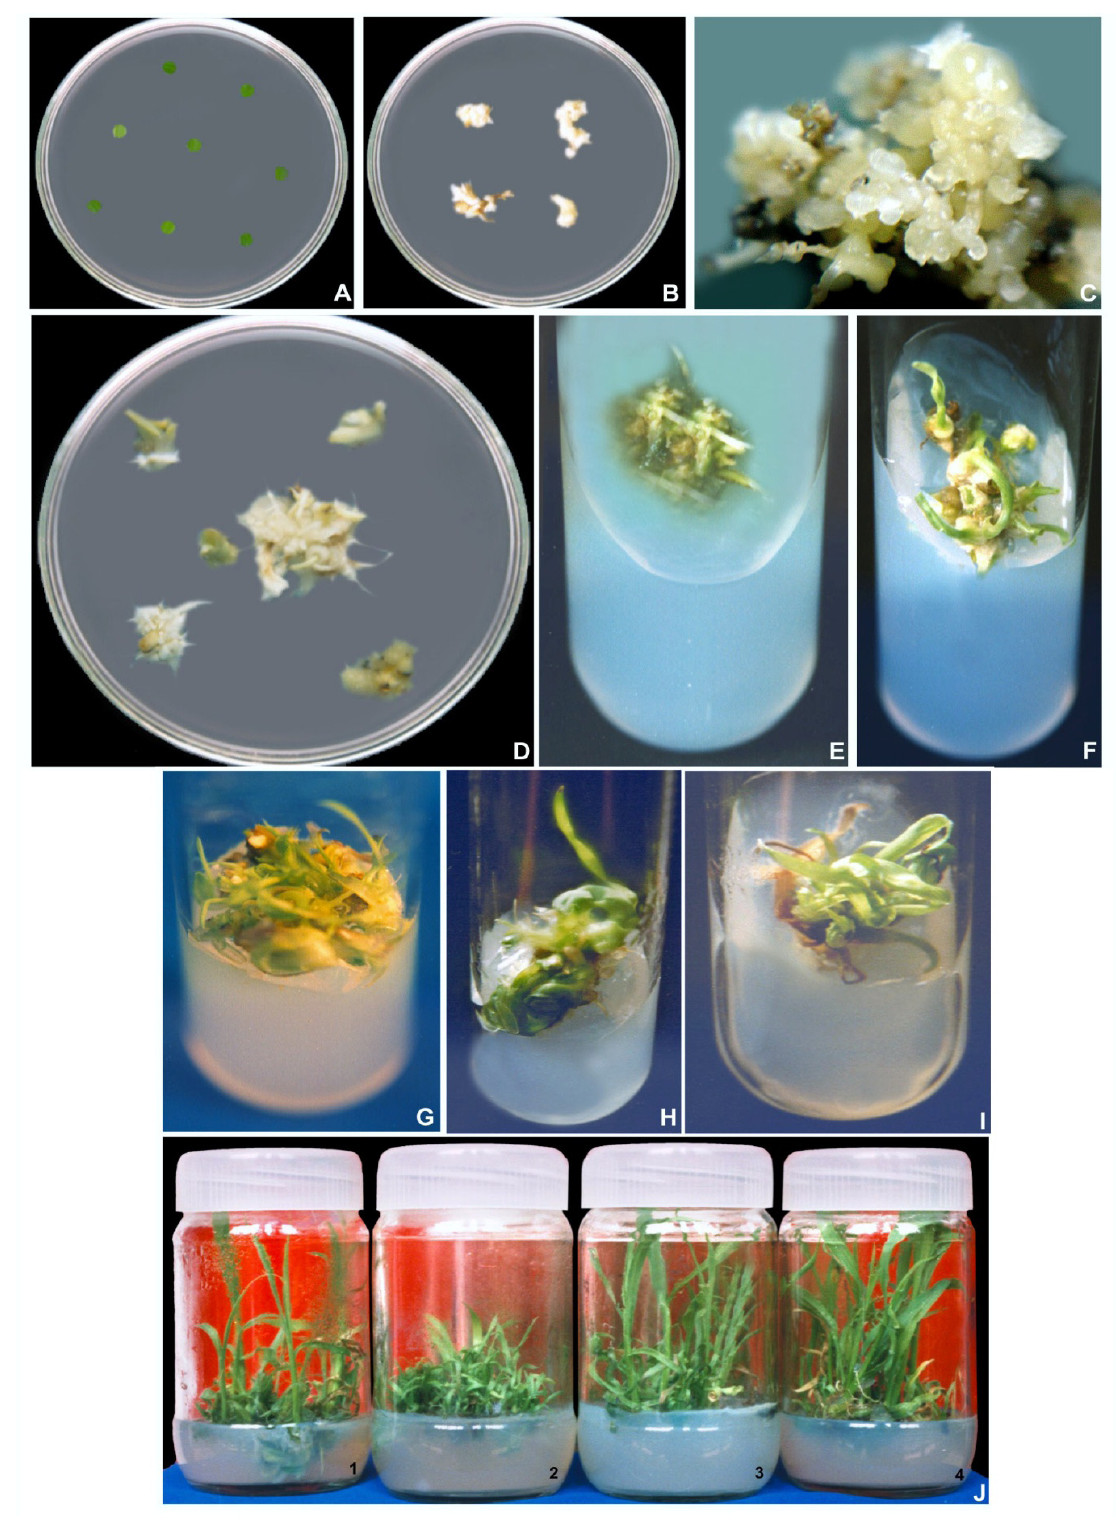
Fig. 1. In vitro plant regeneration from leaf explants of Sorghum